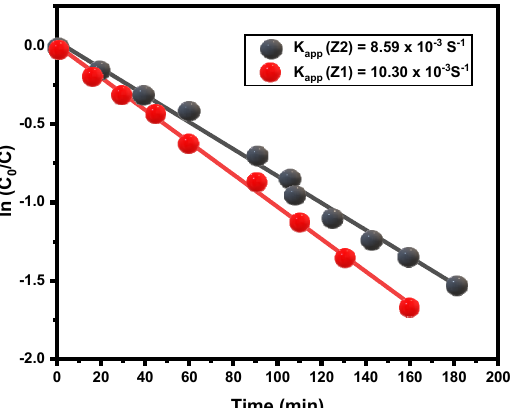
Figure 5. Kinetics plot of the photodegradation rate of reactive yellow dye in the presence of ZQDs.